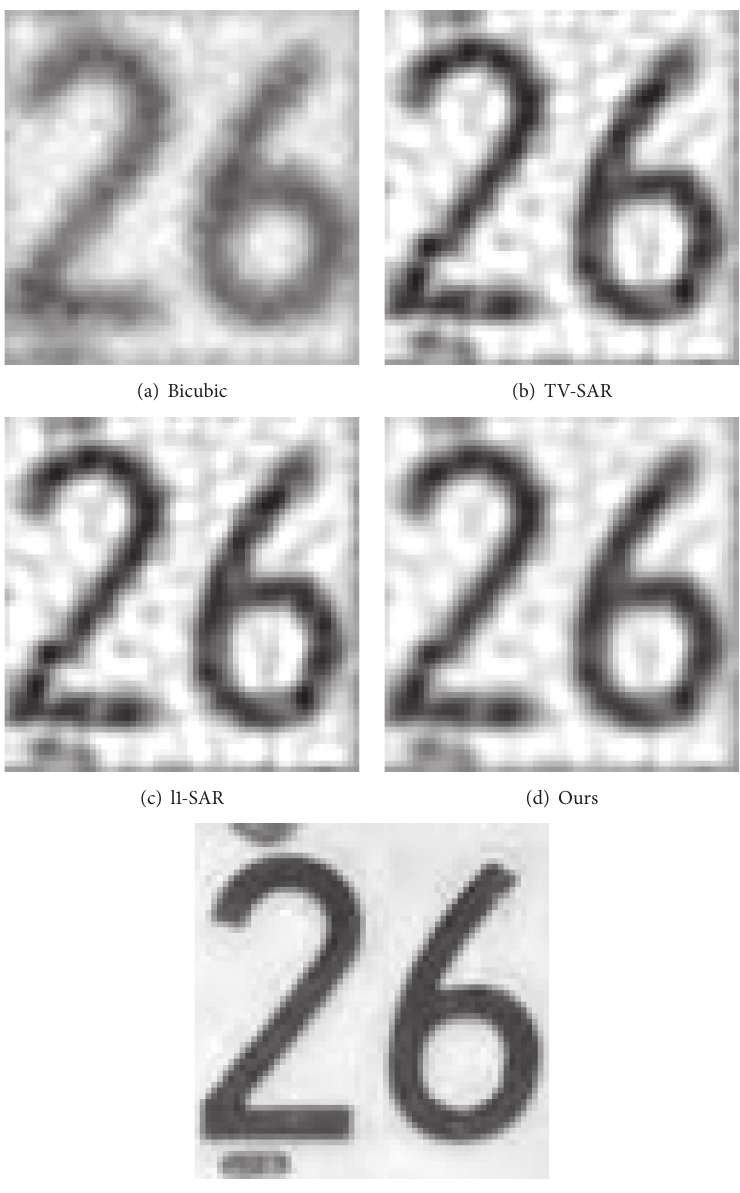
Figure 3: The reconstructed results for Figure 2(a) under white Gaussian noise with 𝜎 = 0.2